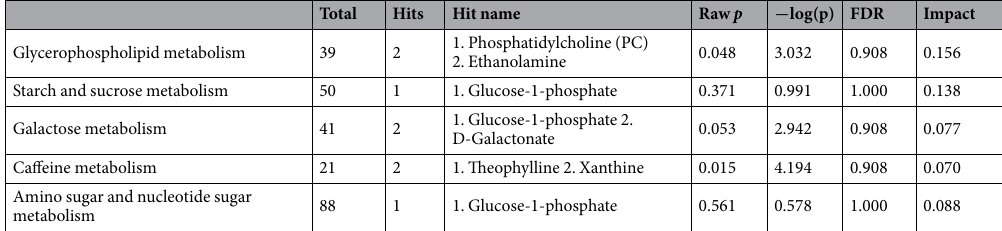
Table 4. Detailed results of pathway analyses based on metabolomics data.